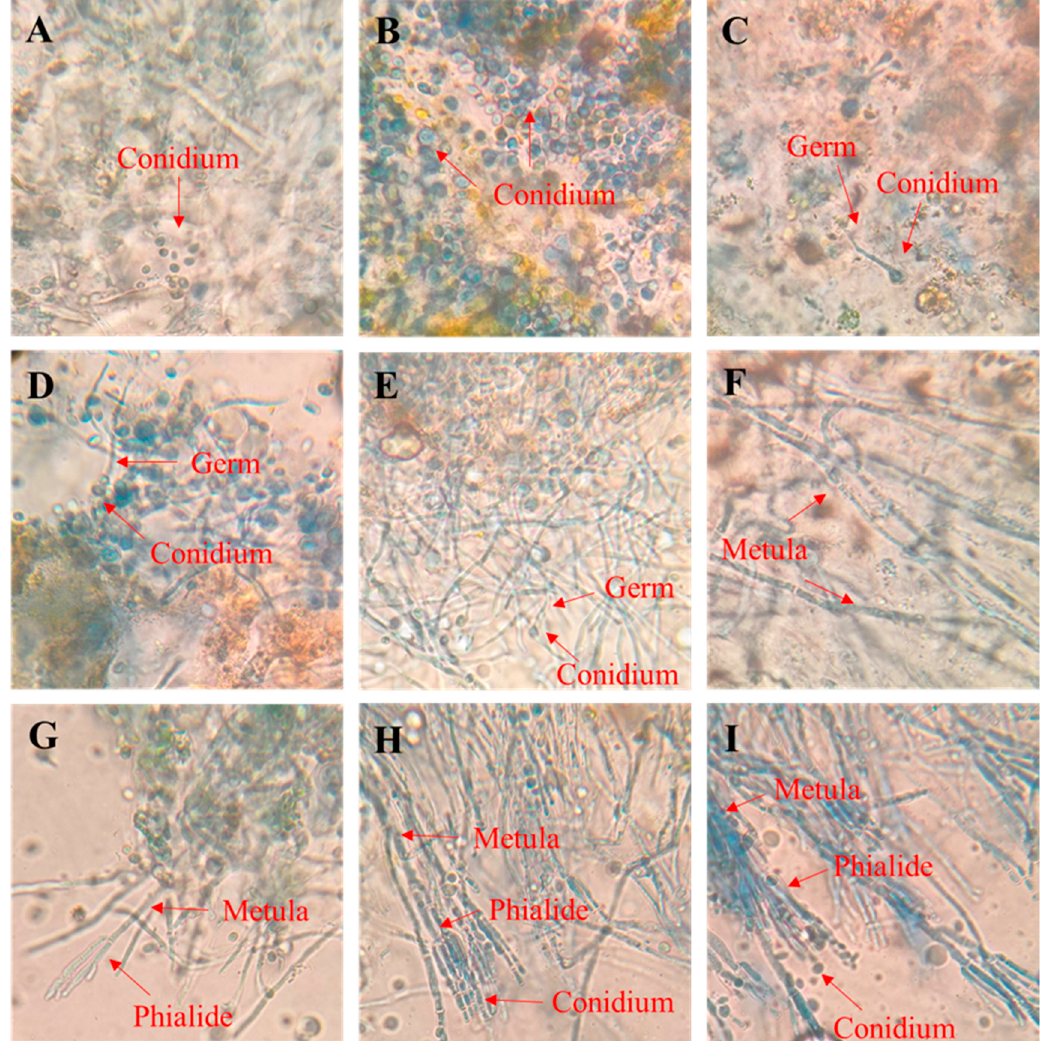
Figure 3. Observation of P. digitatum penetration on wounded citrus tissue at 25 °C . ( A – C ) Citrus tissue inoculated with P. digitatum spores for 0 h, 6 h, 9 h; ( D – F ) Growth of P. digitatum spores in citrus wounds after 12 h, 20 h, 28h; ( G –I) growth of P. digitatum spores in citrus wounds after 36 h, 44 h, 52 h. Scale bar represents 20 µm, and is applicable to ( A – I ).